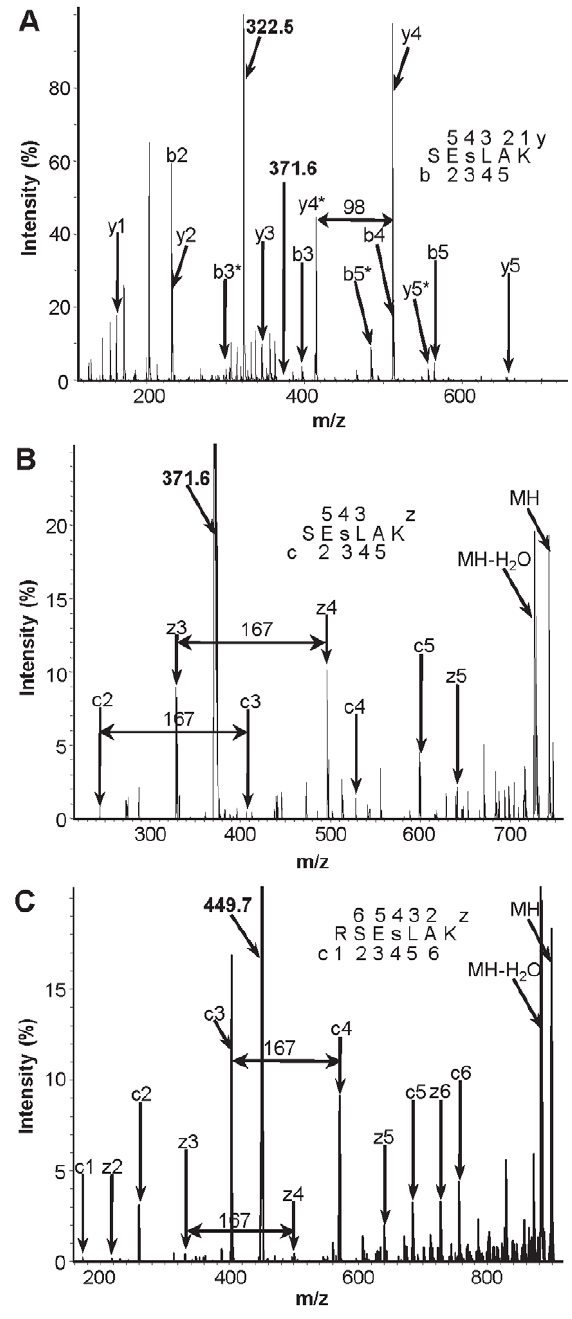
Figure 2. Identification of Ser-231 phosphorylation in the 40S ribosomal protein S6 by mass spectrometric sequencing of two phosphorylated peptides. A , CID spectrum of methylated doubly charged phosphopeptide SEs 231 LAK with mass over charge ratio (M/Z) 371.6, as indicated. The doubly charged ion indicated at M/Z=322.5 corresponds to the parent ion after the neutral loss of phosphoric acid (H 3 PO 4 ; 98 Da). The b (N-terminal) and y (C-terminal) fragment ions are labeled in the spectrum and in the displayed peptide sequence. Lowercase s in the sequence designates phosphorylated serine residue. Phosphorylation site was localized according to the pattern of the fragment ions containing phosphate and corresponding fragments with the neutral loss, which are marked with asterisks. Phosphorylation of the serine residue is evident from the distinct set of the fragments: y4, y4*, and y3, b2, b3, b3*. B, ETD spectrum of the same peptide. The c and z fragment ions are labeled in the spectrum. The indicated mass increment of 167 between z3 and z4, as well as between c2 and